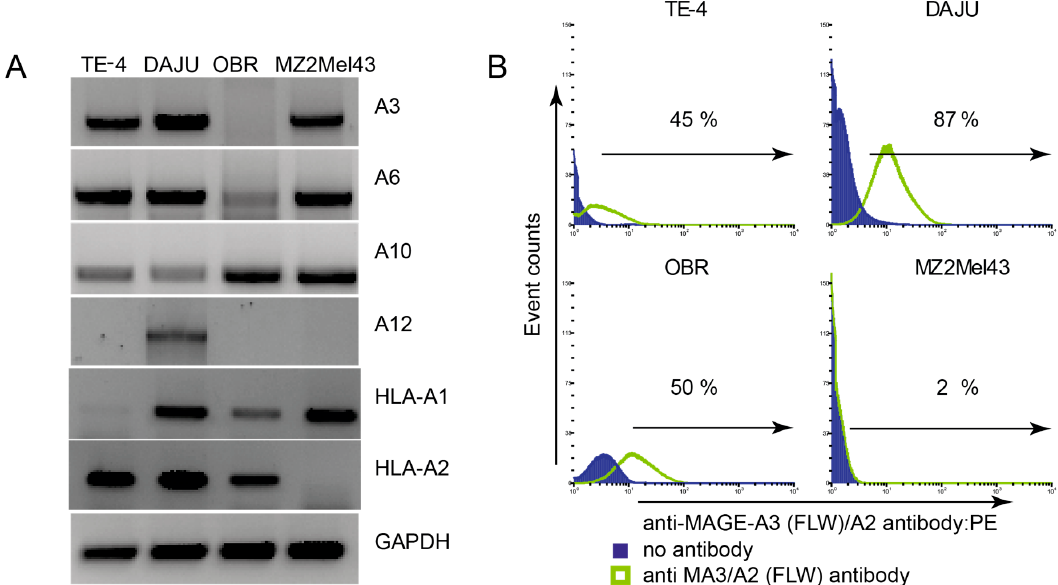
Figure 3. Expression of mMA and HLA by tumour cell lines of different histological origins. ( A ) Expression of various MAGE genes and HLA- A1 and A2 genes are shown together with GAPDH used as a positive control; PCR products were put on agarose gel. ( B ): Tumour cell lines from A were tested for expression of MAGE-A3(FLW)/A2 by flow cytometry. Data are presented as histograms and percentages in plots indicate binding towards tumour cells. Figure S1: Complete PCR Gel showing the expression of MAGE A3 on tumor cell lines, Figure S2: Complete PCR Gel showing the expression of MAGE A6 and MAGE A10 on tumor cell lines, Figure S3: Complete PCR Gel showing the expression of MAGE A6, MAGE A10 and MAGE A12 on tumor cell lines, Figure S4: Complete PCR Gel showing the expression of MAGE A1, HLA A1, HLA A2 and GAPDH on tumor cell lines.